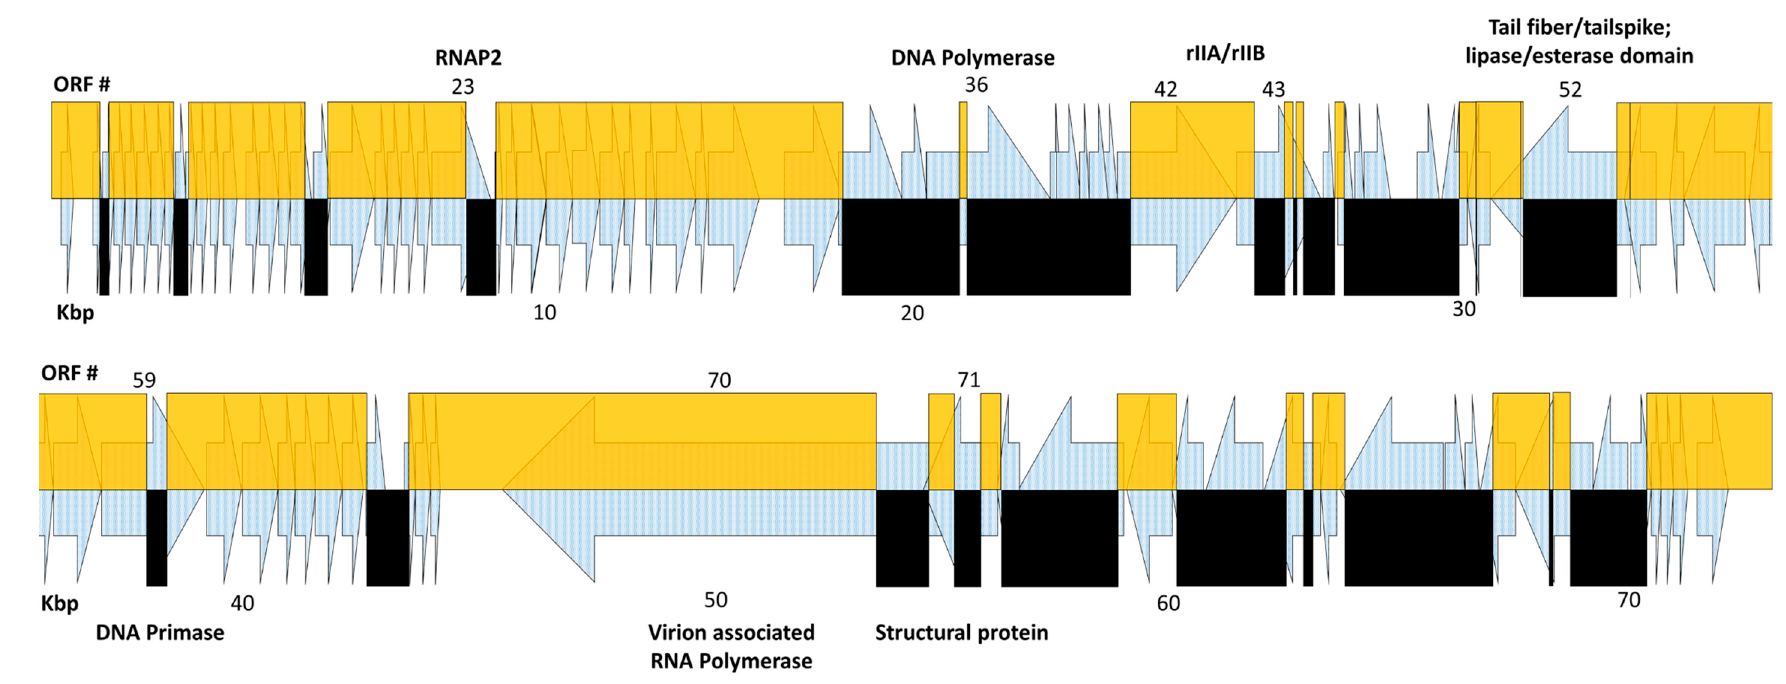
Figure 2. Schematic representation of the phi176 genome and its recombinatorial derivation. Open reading frame (ORF) numbers are shown at the top, and genome position (Kbp) at the bottom. Arrows represent individual ORFs. Yellow boxes denote genetic material of Pa2 origin, and black boxes represent RWG-derived sequences in the recombinant phi176 genome. The putative function of key recombinant genes (Table 5) are shown in bold above and below the map.